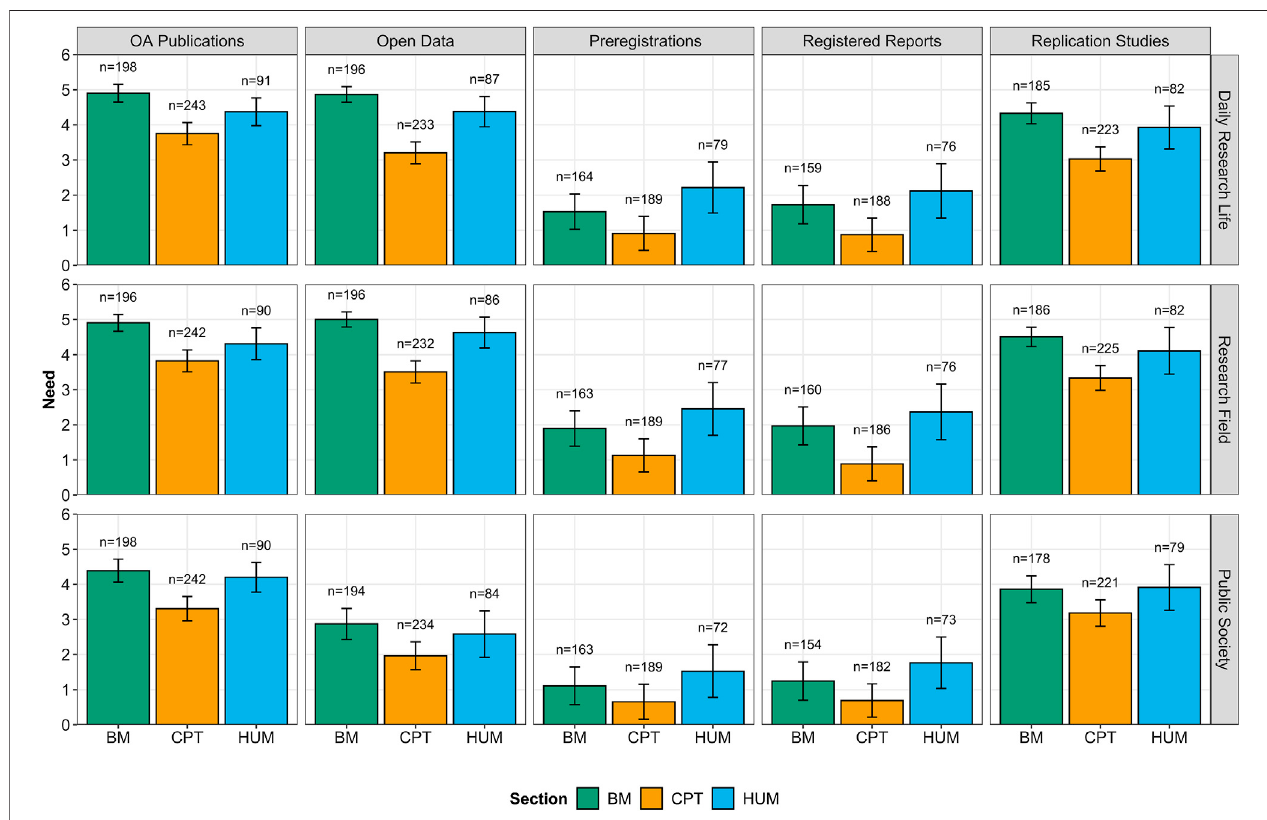
FIGURE 3 | Perceived need of ECRs regarding OS practices from different perspectives (i.e., daily research life, research fi eld, and public society) aggregated by sections (BM: biology and medicine, CPT: chemistry, physics, and technology, and HUM: humanities). Error bars represent 95% con fi dence intervals (CIs).